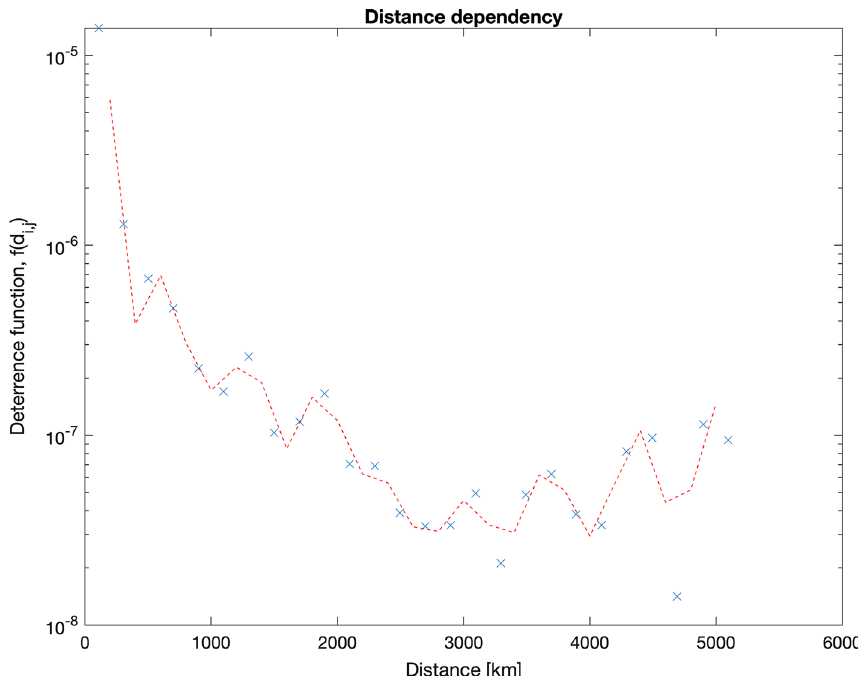
Fig. 2 Distance deterrence function